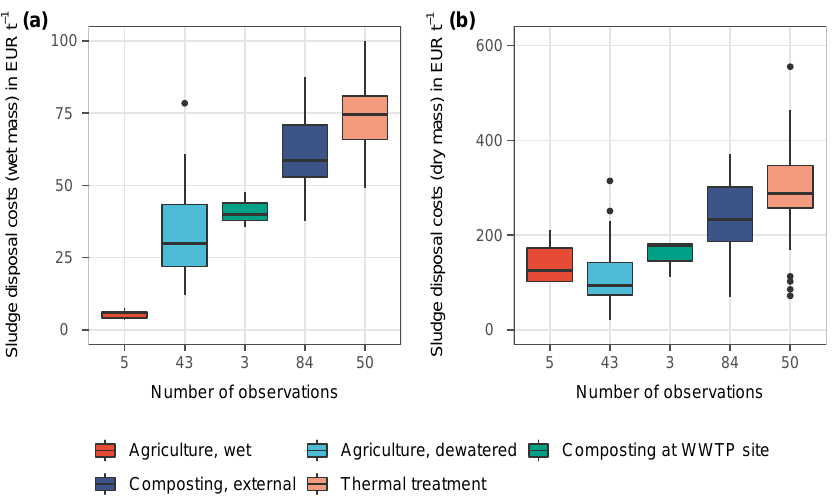
Figure 9. Cost of sludge disposal in Euro per ton as a function of their disposal route ( a ) based on sludge wet mass and ( b ) based on sludge dry mass. Statistical values are provided in Tables S7 and S8.